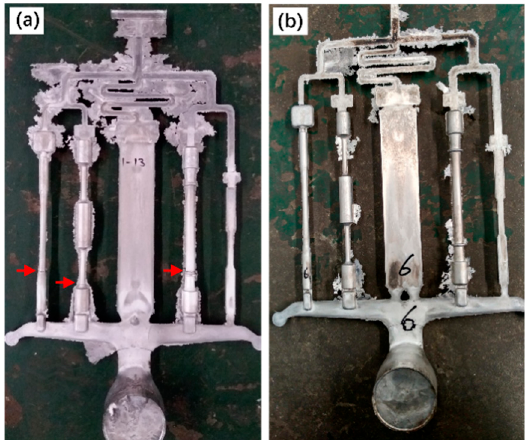
Figure 3. Appearance of the specimens of die-cast ( a ) ZA64 and ( b ) ZAT642 alloys.